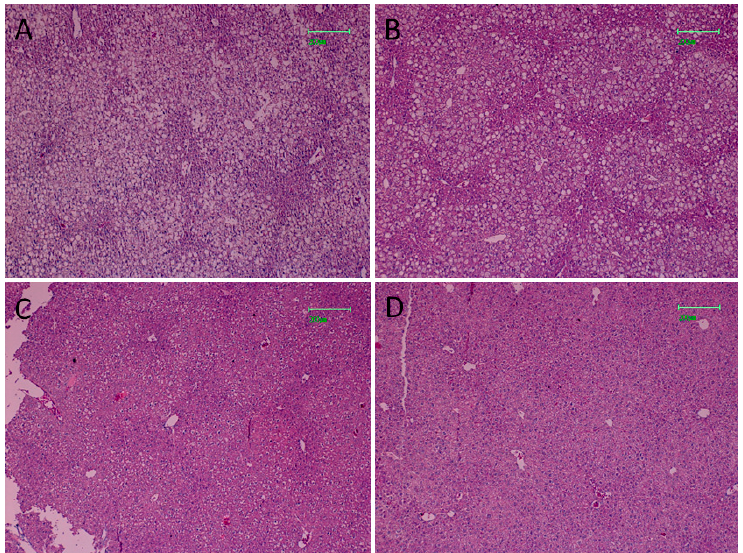
Figure 6. Hepatic histological morphology observed in the HFD group ( A ), HFD + FLS 30 group ( B ), HFD + FLS 60 group ( C ) and Control group ( D ). Magnification: 10×, bars = 200 µM.